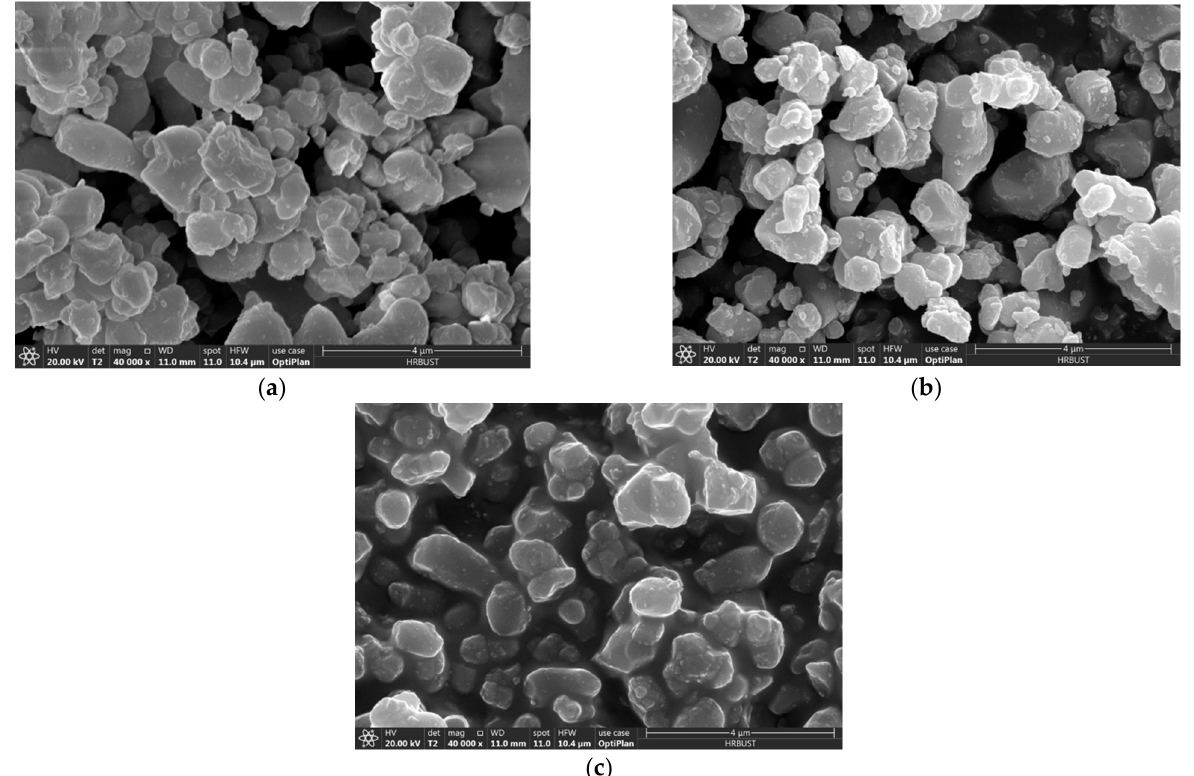
Figure 4. SEM of CCTO particles modified by the silane coupling agent: ( a ) KH550 modified CCTO; ( b ) KH560 modified CCTO; ( c ) KH570 modified CCTO.